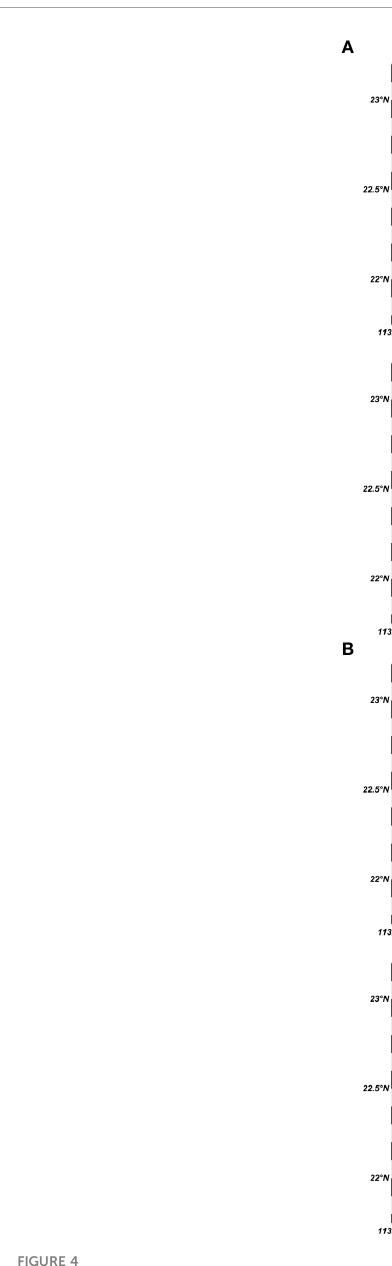
FIGURE 4 Spatiotemporal pattern of TN (A) and TP (B) in the